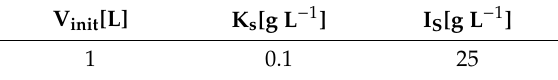
Table A12. Initial concentration volume V init . Model parameters for the monod constant substrate K S and substrate inhibition constant I S . Parameters estimated by adaptation to previous